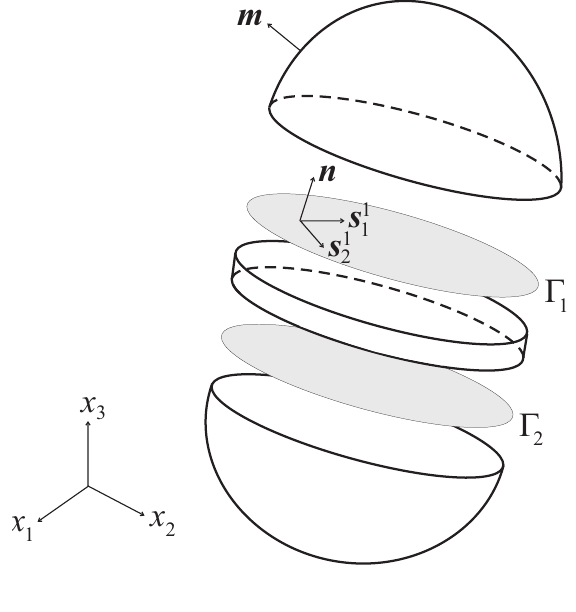
Figure 1. Notation adopted for layered bodies (here n